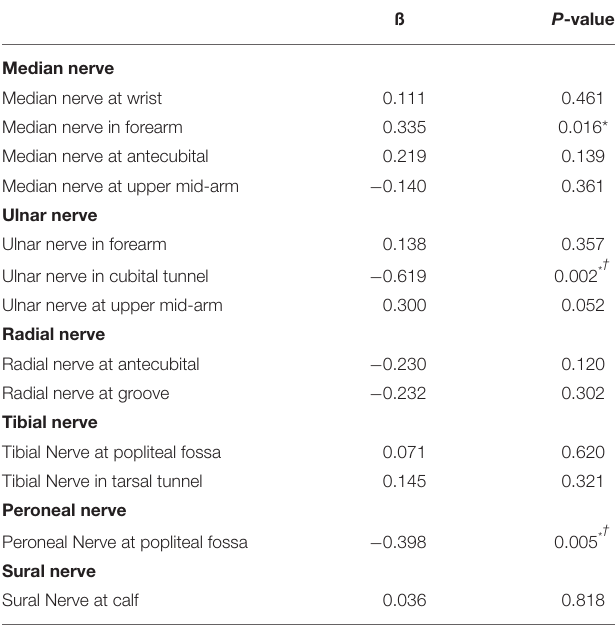
TABLE 3 | Peripheral nerve cross-sectional area reference values according to